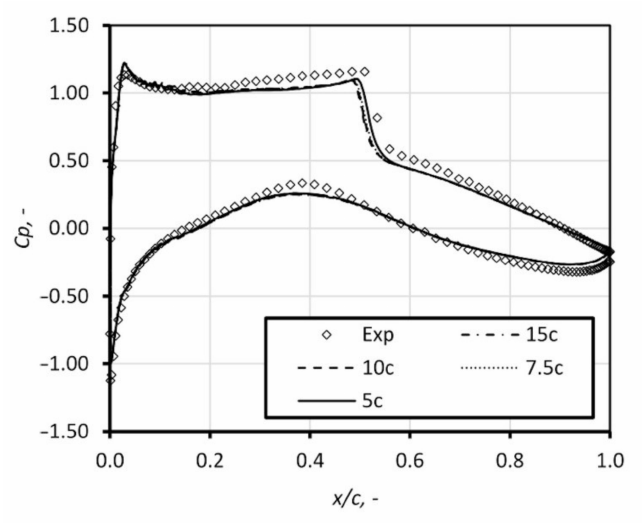
Figure 10. The domain size influence on the pressure coe ffi cient distribution on the airfoil surface.